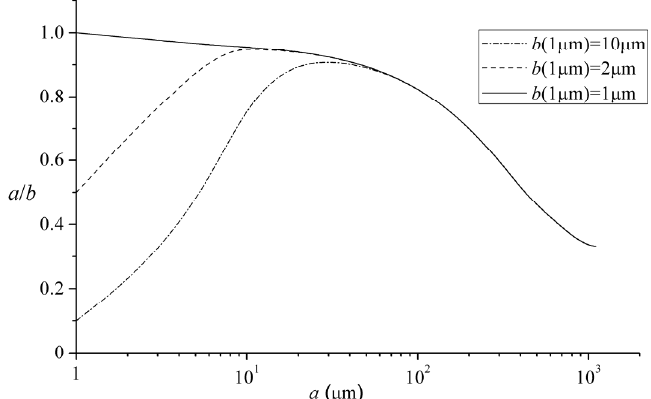
Figure 5: Crack aspect evolution for different initial crack aspect .